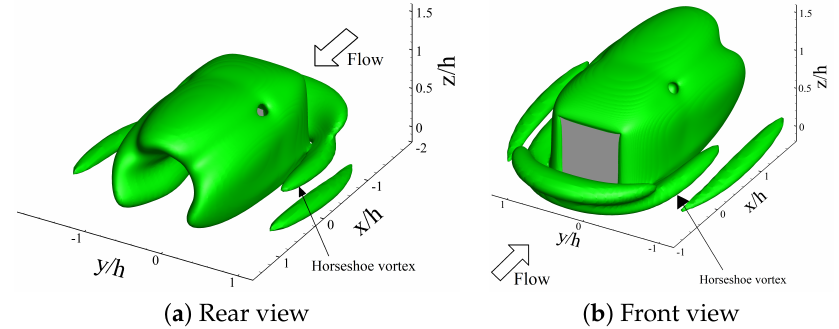
Figure 13. The isosurface of Q ∗ = 4.42 × 10 − 2 in the wake of the square